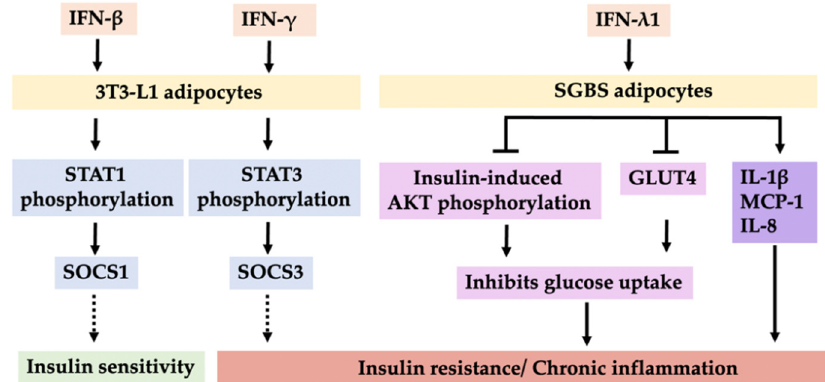
Figure 2. Schematic model of different mechanisms of insulin sensitivity and resistance by IFNs in 3T3-L1 adipocytes and SGBS adipocytes.